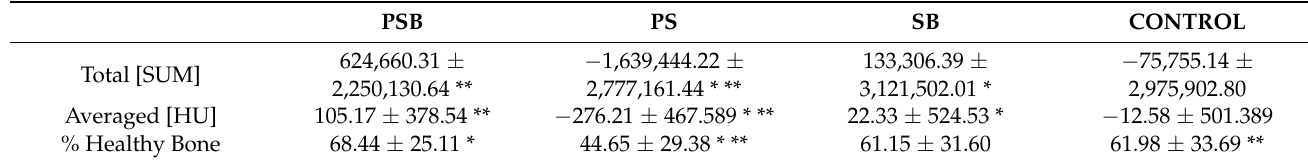
Figure 3. 3D reconstructions of the PPB ( A , B ) and SB group after 3 weeks ( C , D ). Region of interest (ROI) on image D with new bone formation inside the defect (arrow). The images present a calibration of 1 µ m. The colour range oscillates between 250–1000 HU. Table 1. Radiological results (total HU of bone density of the area studied per group, median of said measurement per group and % of regenerated bone per group) after 3 weeks. The statistically significant differences are shown in the same row by pairs of similar symbols ( * , ** ; p < 0.05).